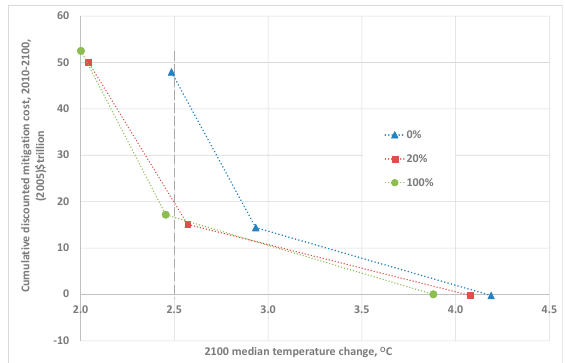
Figure 10. Costs of achieving different long-term temperature goals with varying degrees of non-CO 2 mitigation (in terms of CO 2 e prices as a fraction of CO 2 prices).